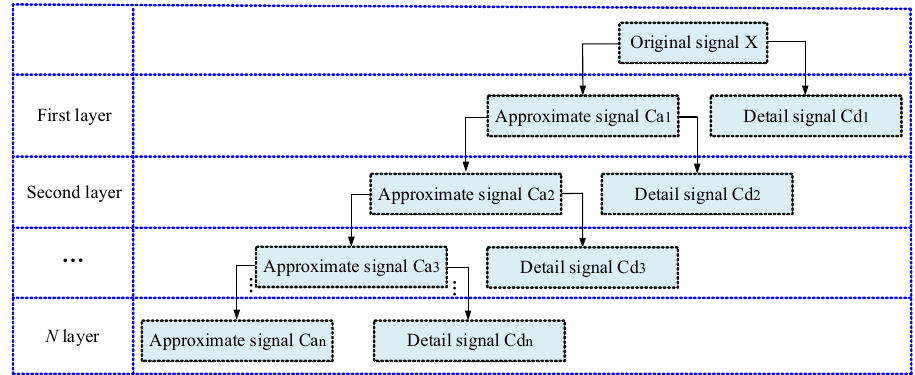
Figure 3. Signal multilevel wavelet decomposition